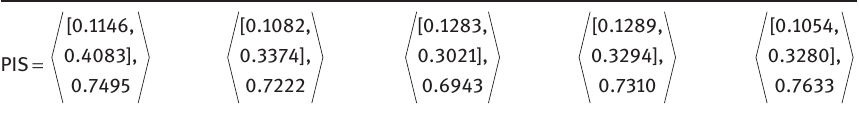
Table 12: Positive Ideal